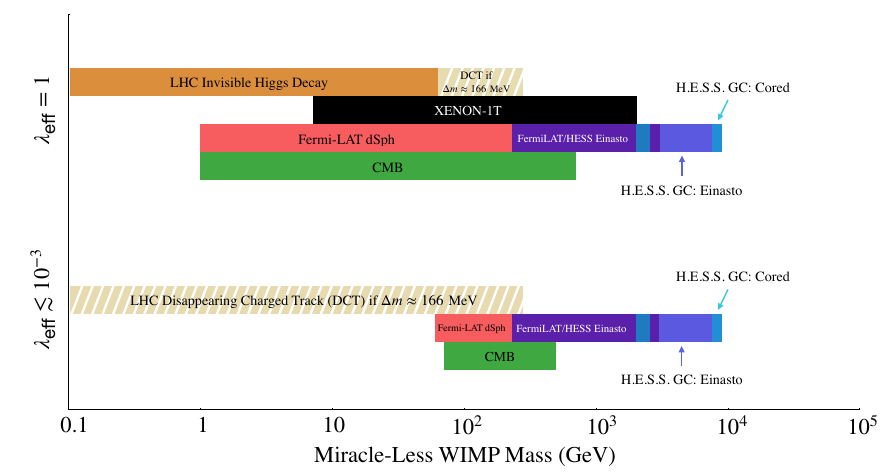
Is a Miracle-Less WIMP Ruled Out?